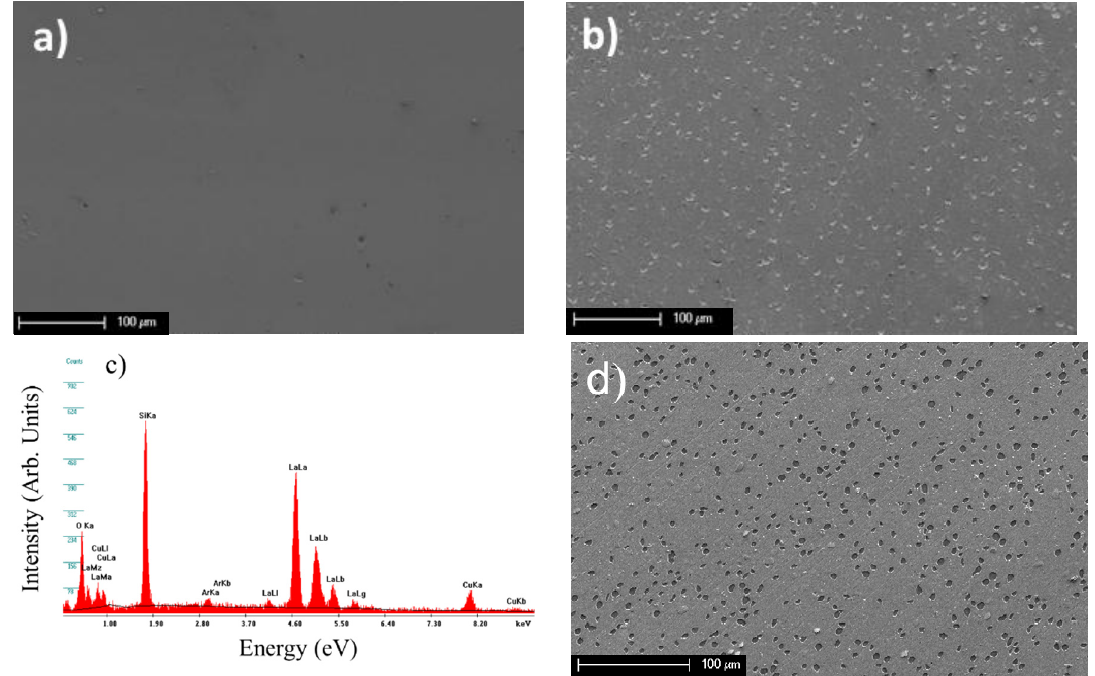
Figure 4. Surface morphology of a La 2 CuO 4 thin film ( a ) as-deposited, ( b ) after an air annealing during two hours at a temperature of 600 °C, ( c ) EDS spectrum obtained on the adherent film from Figure 4b, and ( d ) after a vacuum annealing (2 h at 600 °C).